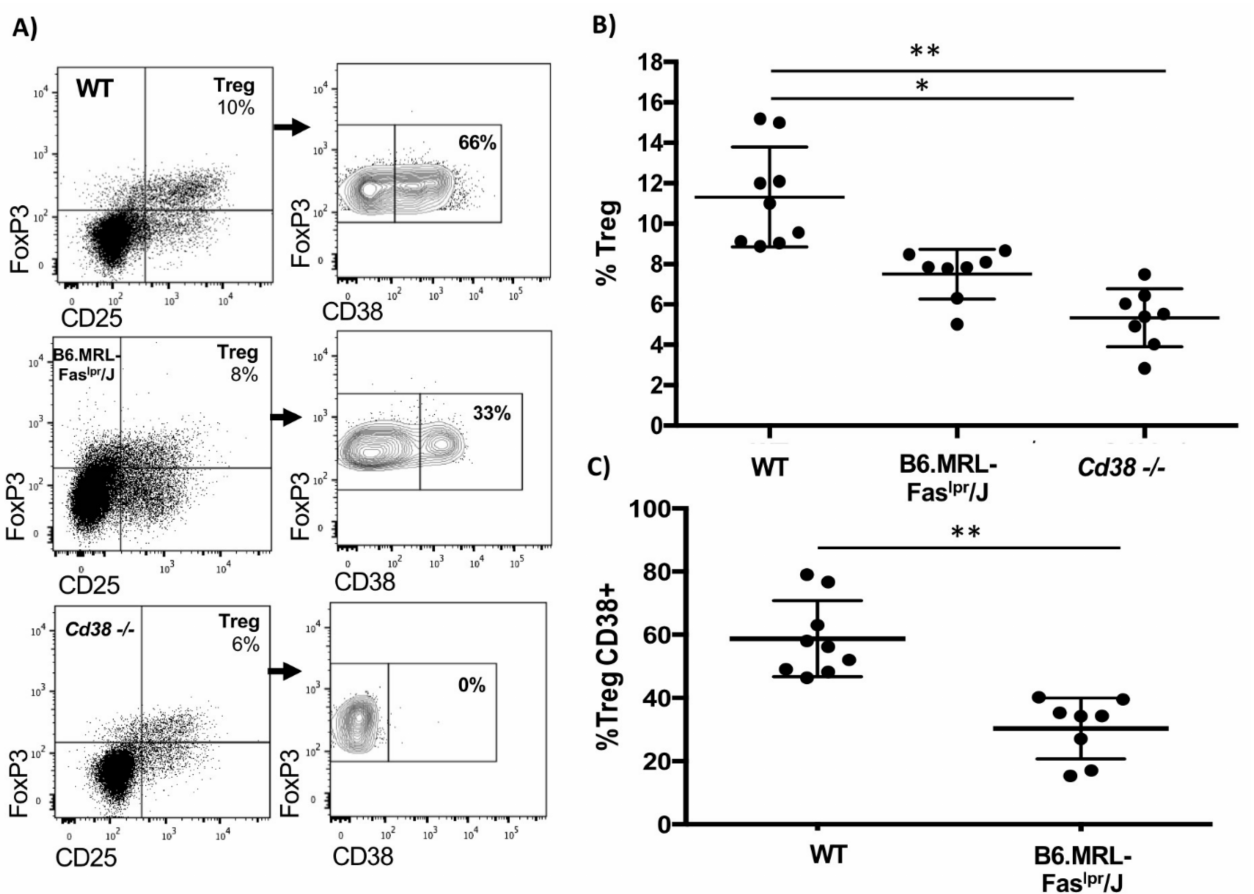
Figure 3. Reduced CD38 + Treg levels in B6.MRL-Fas lpr /J mice. ( A ) Representative dot plots of the frequency of Treg cells in splenocytes from WT, B6.MRL-Fas lpr /J and CD38-/- . The dot plots’ right is representative contour plots showing CD38 expression gated on splenic Treg cells from WT ( n = 9), B6.MRL-Fas lpr /J ( n = 8), and CD38-/- mice ( n = 8); ( B ) scatter dot plot shows mean ± SD of Treg frequency from WT, B6.MRL-Fas lpr /J and CD38-/- mice. Statistical analysis was performed using one-way ANOVA. Differences between groups were indicated by Tukey post hoc test, where * p < 0.001, ** p < 0.0001; ( C ) scatter dot plot shows mean ± SD of CD38 + Treg frequency from WT and B6. MRL-Fas lpr /J mice. Statistical analysis was performed using Student t -test, where ** p <